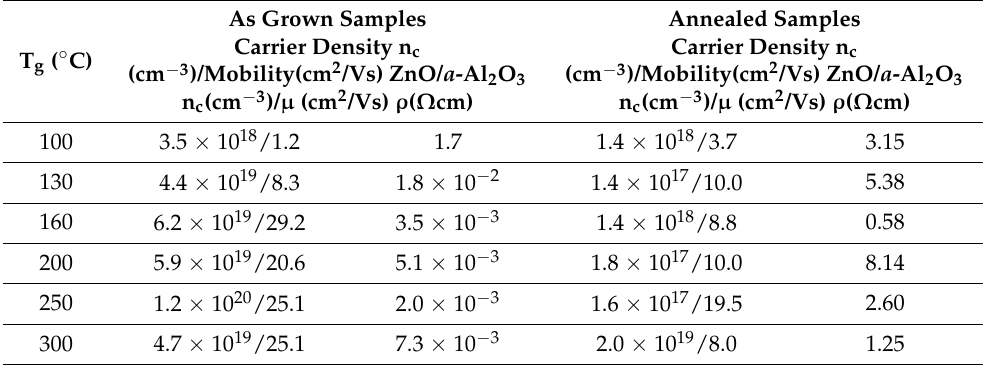
Table 3. Electrical parameters and thickness of as grown and annealed ALD- ZnO/ a -Al 2 O 3 thin films. As Grown Samples T g (°C ) Carrier Density n c (cm −3 )/Mobility(cm 2 /Vs)